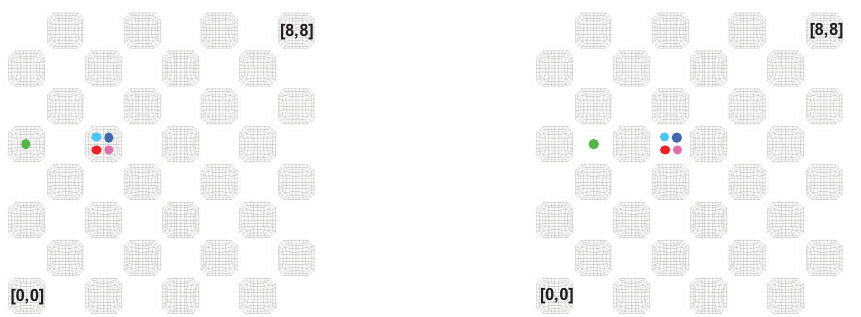
Figure 10: List of evaluated channels for each variant